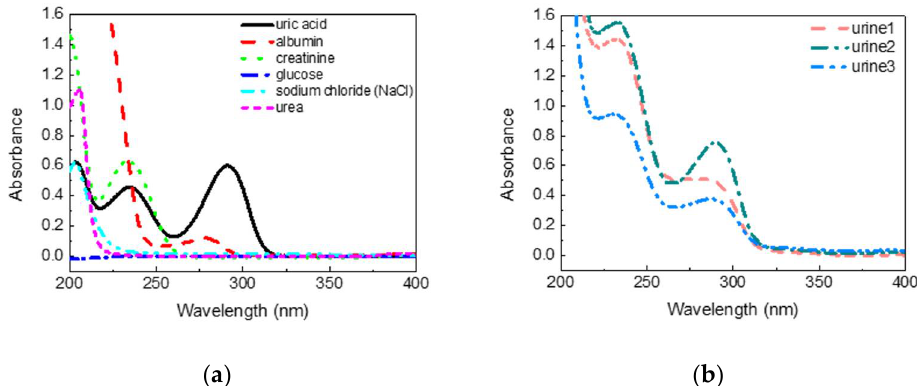
Figure 2. ( a ) The absorption spectra of common substances in the urine; ( b ) the absorption spectra of diluted urine of three different people. diluted urine of three different